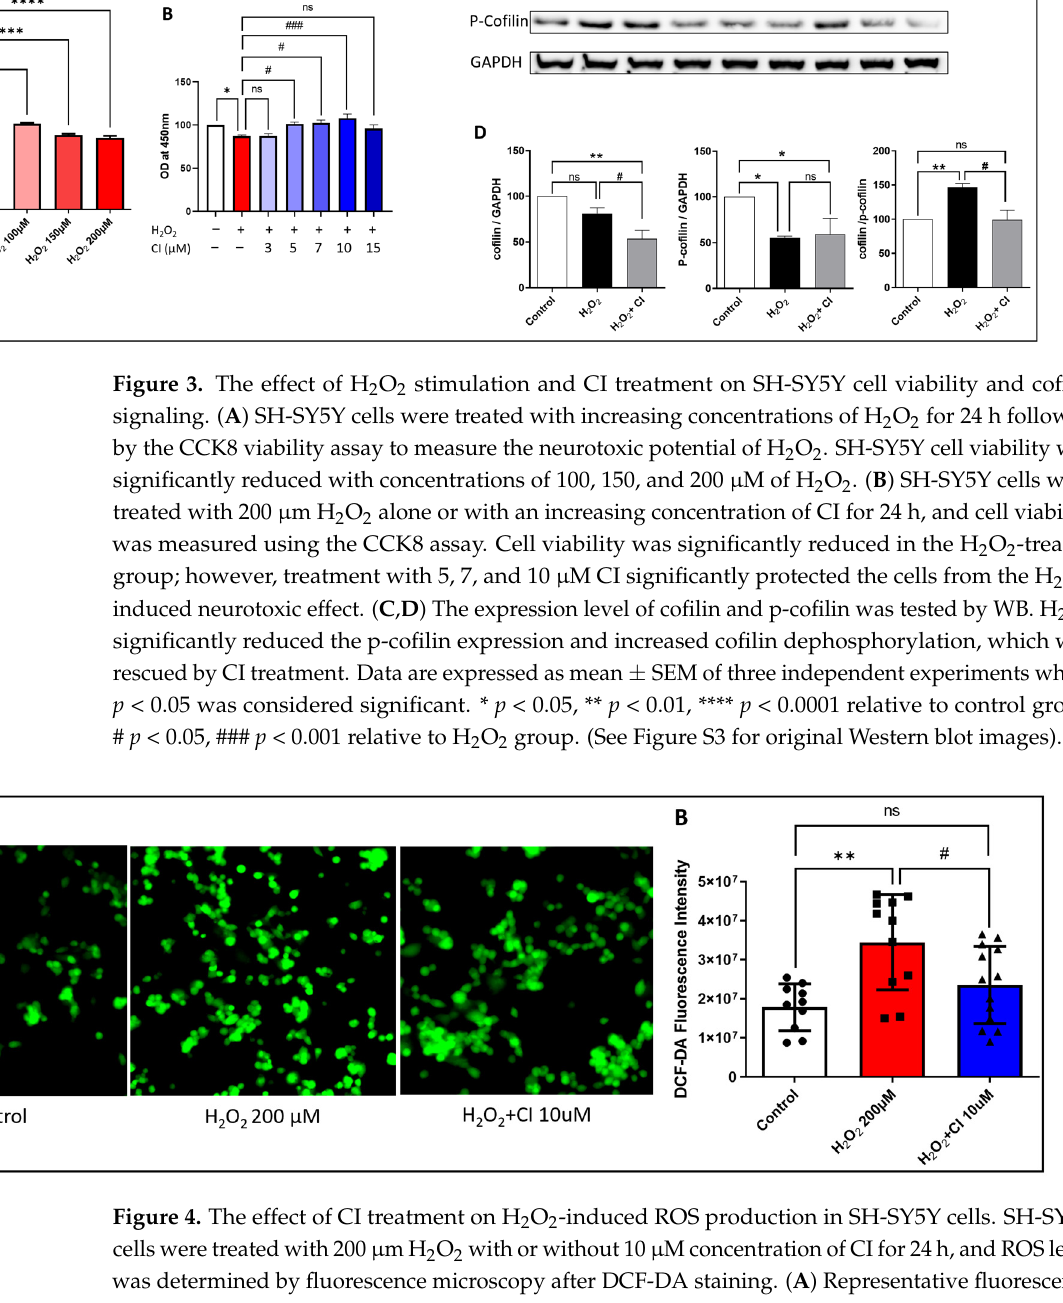
Figure 4. The effect of CI treatment on H 2 O 2 -induced ROS production in SH-SY5Y cells. SH-SY5Y cells were treated with 200 μ m H 2 O 2 with or without 10 μ M concentration of CI for 24 h, and ROS level was determined by fluorescence microscopy after DCF-DA staining. ( A ) Representative fluorescence images of DCF-DA staining SH-SY5Y cells. ( B ) Quantifying green fluorescence intensity showed a significant reduction of ROS levels in the CI-treated group compared to the H 2 O 2 -stimulated group. Data are expressed as mean ± SEM of three independent experiments where p < 0.05 was considered significant. ** p < 0.01 relative to the control group. # p < 0.05 relative to H 2 O 2